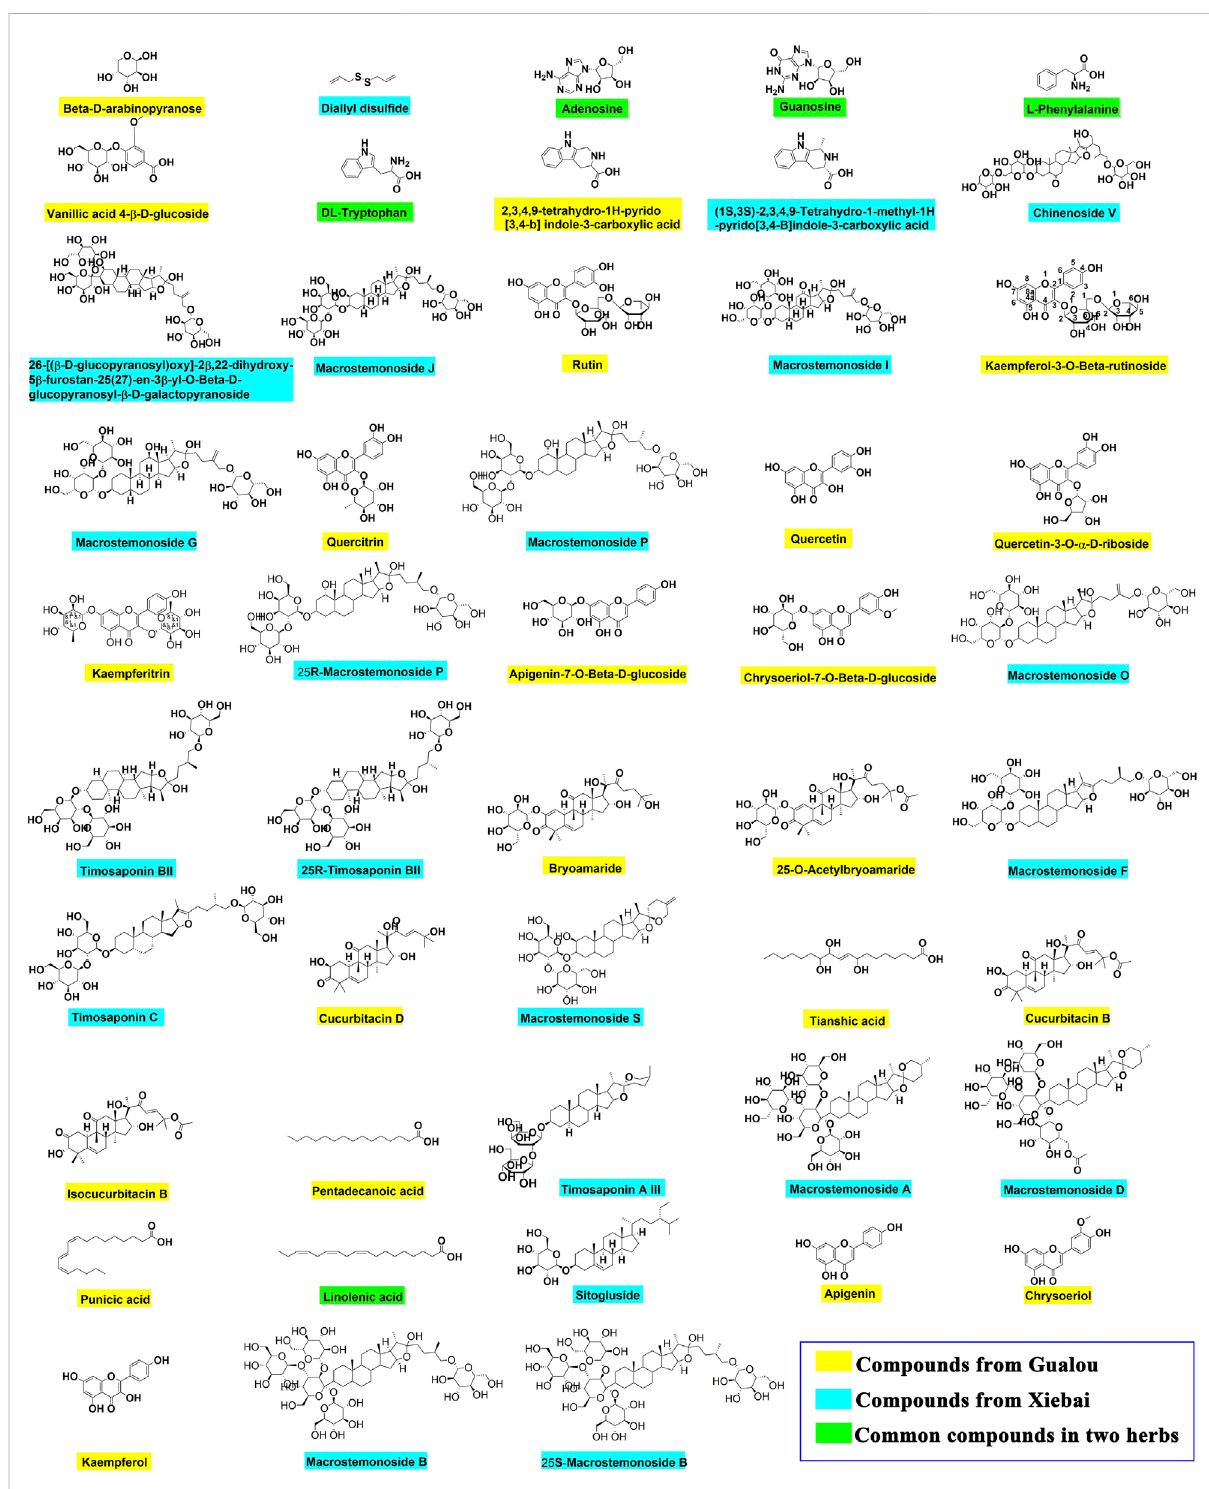
FIGURE 3 The chemical structures of main compounds from GLXB and the single herbs based on analysis of HPLC-Q-TOF-MS and information retrieval. Compounds from Gualou: labeled as yellow nodes; compounds from Xiebai: labeled as blue nodes; common compounds in two herbs: labeled as green